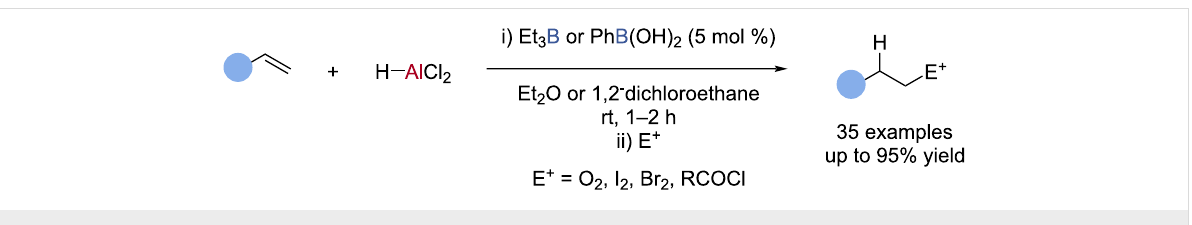
Scheme 18: Borane-catalysed hydroalumination of alkenes and